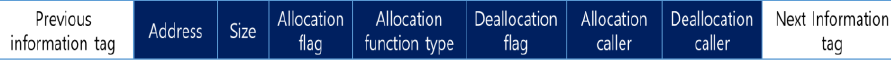
Figure 3. Information tag.